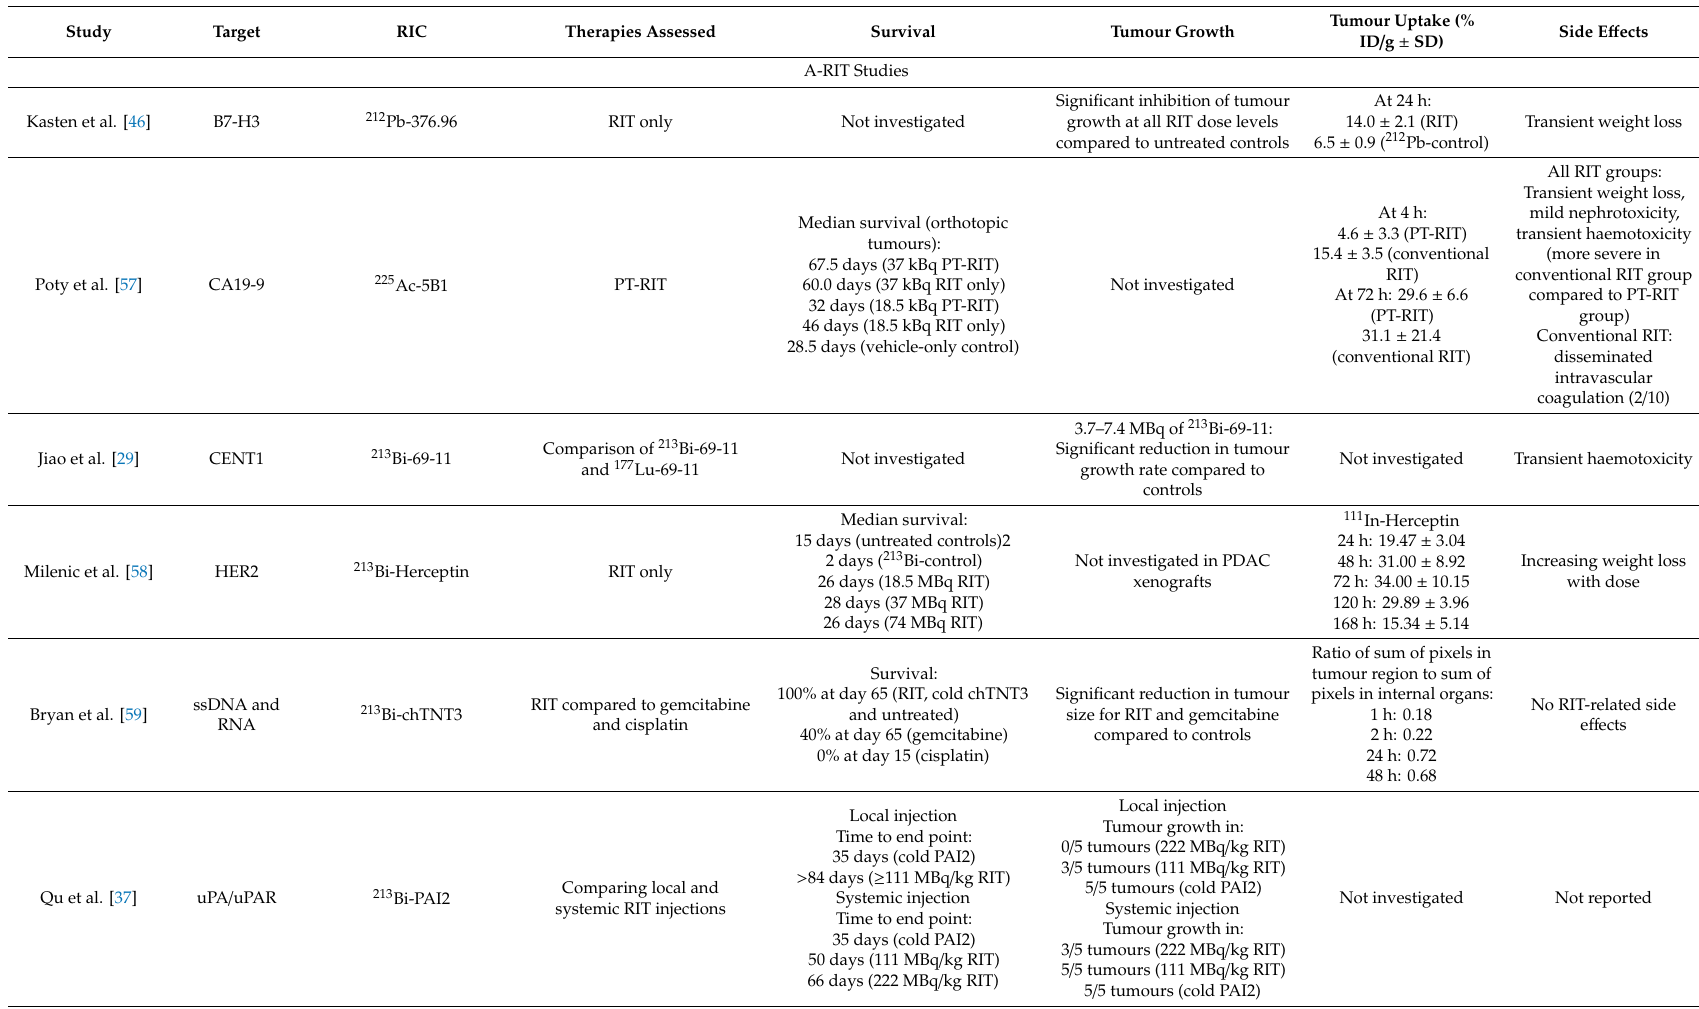
Table 4. In vivo studies performed using α and β RIT in